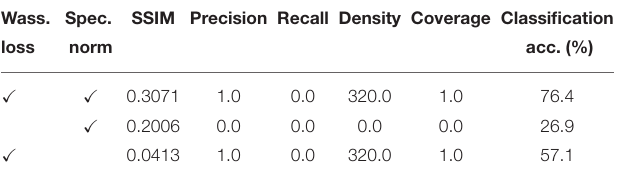
TABLE 4 | Ablation study to demonstrate the performance impact of using Wasserstein loss and Spectral normalization. Wass. Spec. SSIM Precision Recall Density Coverage Classification loss norm acc.